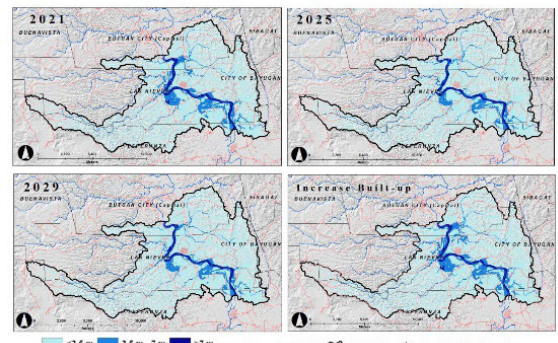
Figure 8. Flood depth maps with a 5-year rainfall return period